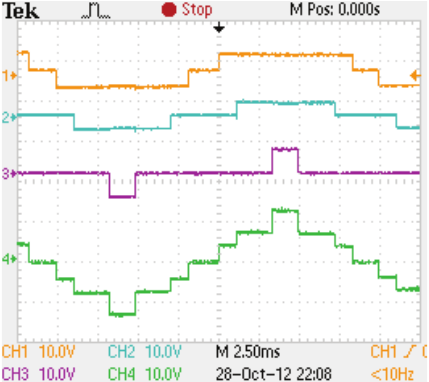
Figure 20: Three-stage 7-level staircase waveform.